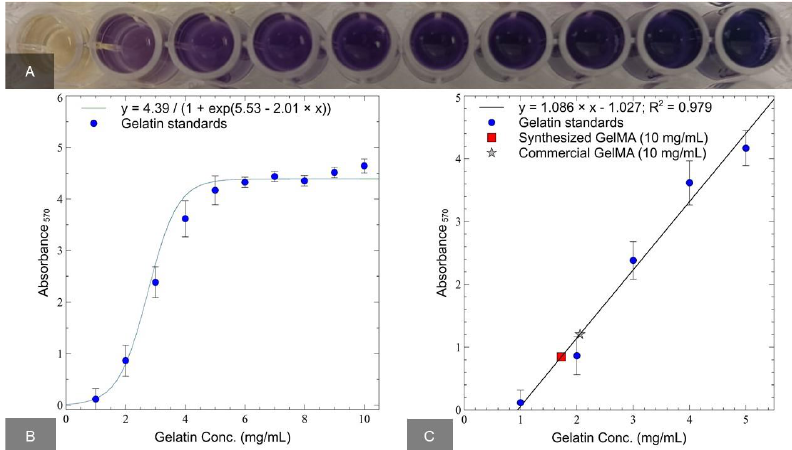
Figure 1. Ninhydrin assay. An example of coloring gelatin at a concentration of 1 – 10 mg/mL to obtain a standard curve using ninhydrin analysis ( A ). The value of the optical density of gelatin from 1 – 10 mg/mL ( B ). The linear section of the standard curve, which was used to build a linear approximation ( C ).